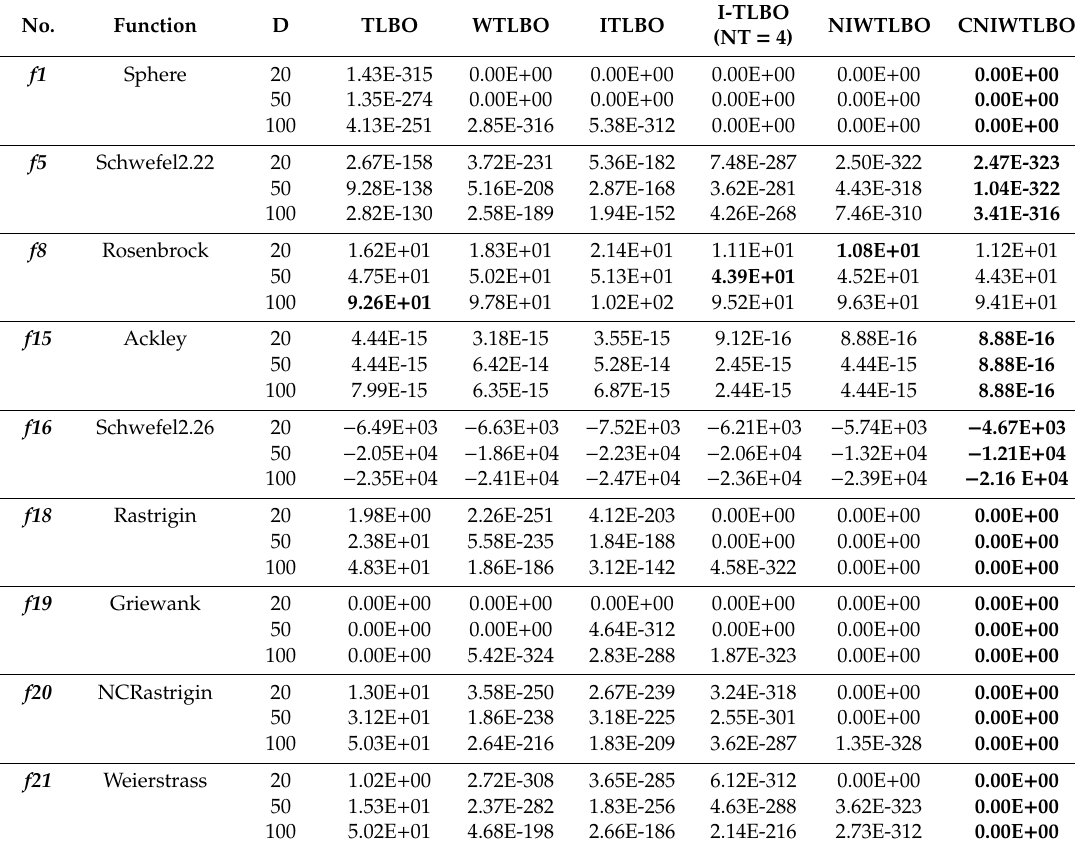
Table 7. Comparative results of CNIWTLBO and di ff erent variants of TLBO